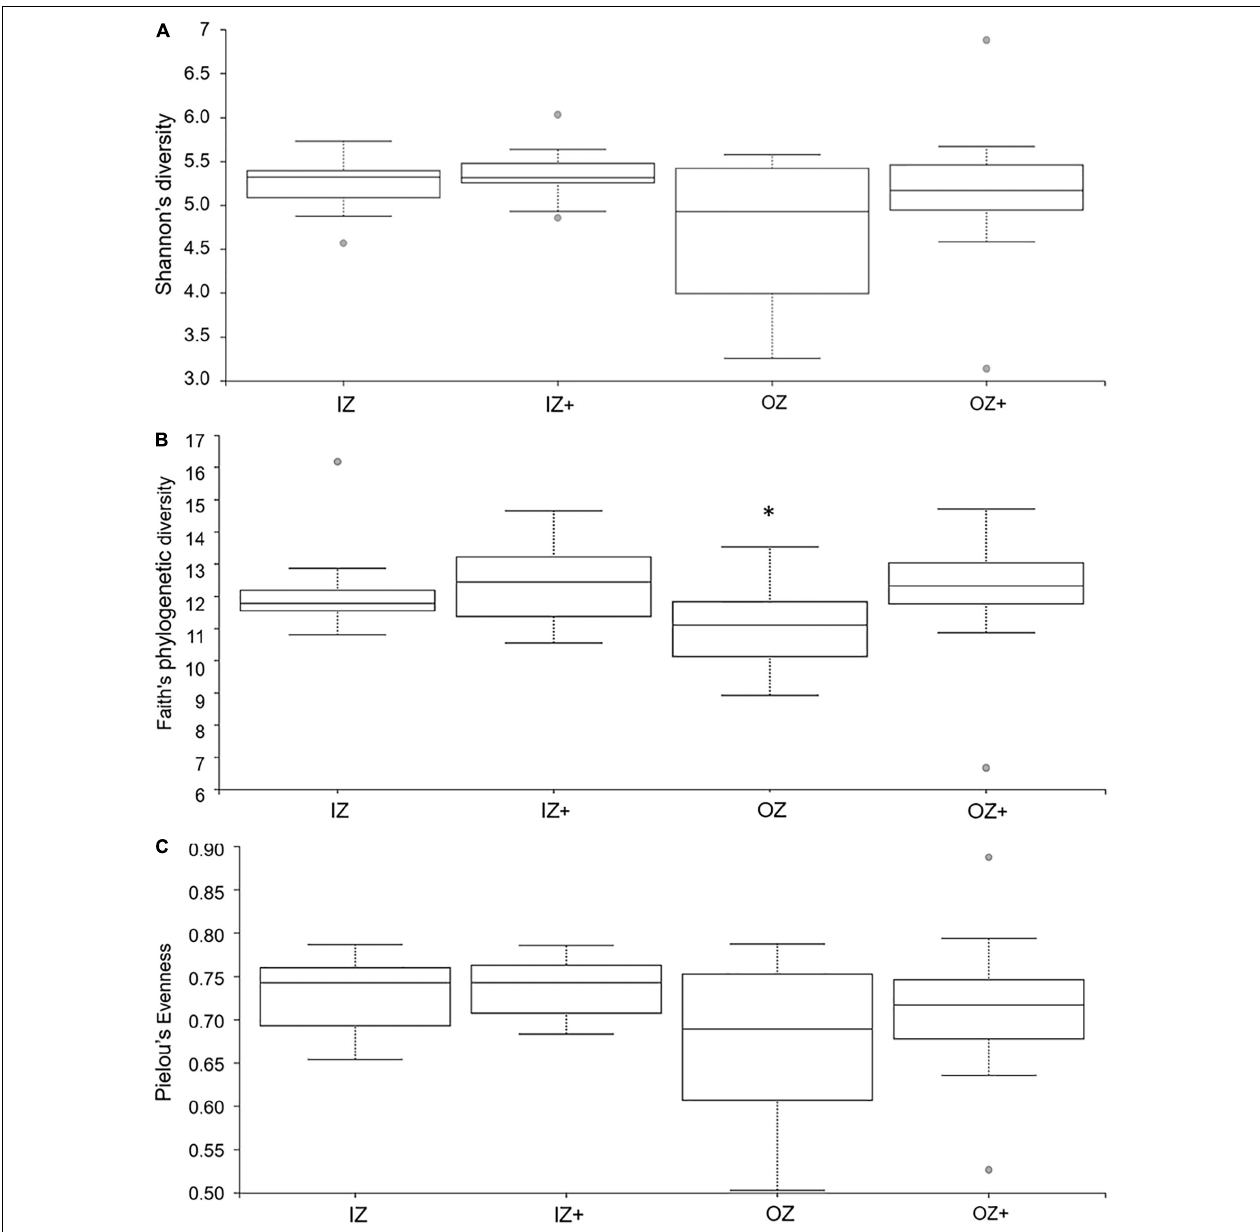
FIGURE 1 | Boxplot of alpha diversity indices calculated for fecal bacteria associated with diets supplemented with inorganic (IZ and IZ +) and organic (OZ and OZ +) Zn sources without (IZ and OZ) and with (IZ + and OZ +) the addition of a multi-enzymatic complex from the solid-state fermentation of Aspergillus niger. Boxes represent the interquartile range between the first and third quartiles, and the horizontal line inside the box defines the median. Whiskers represent the lowest and highest values, not considering outliers, represented by the dots. (A) Shannon’s diversity, (B) Faith’s phylogenetic diversity, and (C) Pielou’s evenness. *Statistically significant ( p <